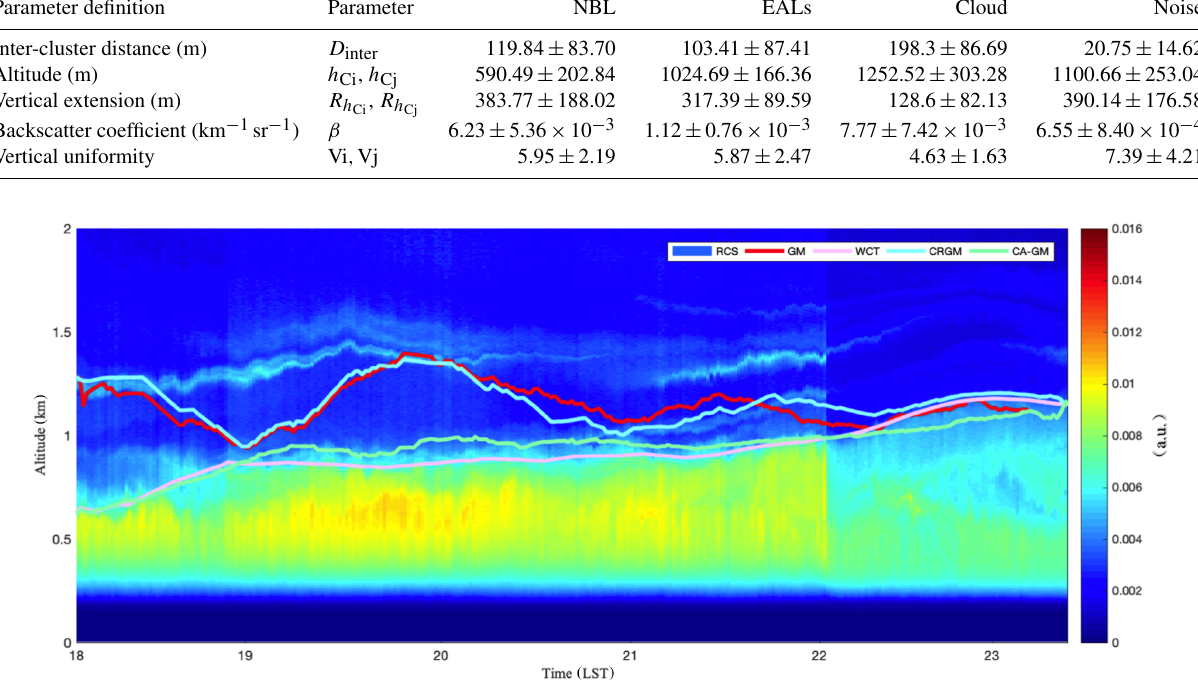
Figure 6. Time–height cross section of range-corrected signal (RCS) with four NBLH retrieved methods on 23 December 2016.